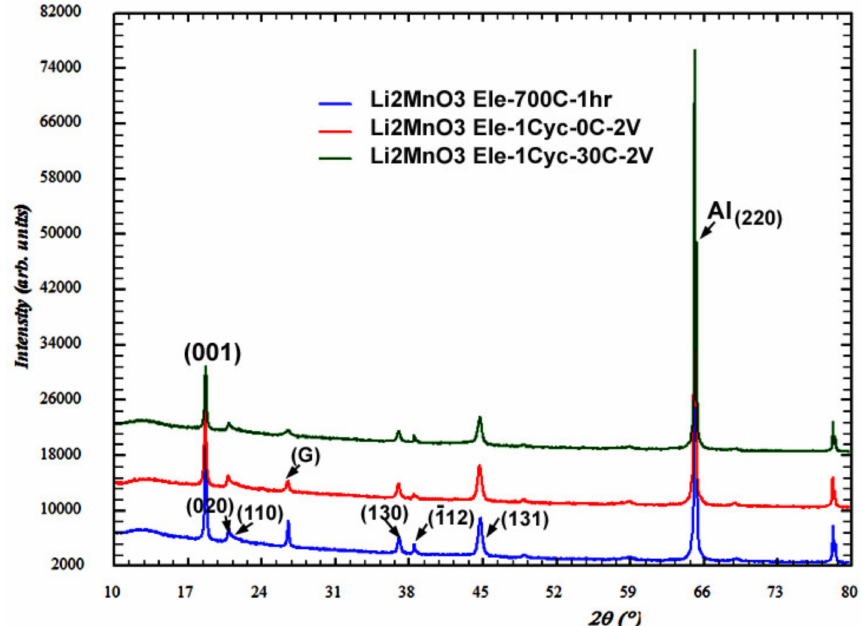
Figure 7. Comparison of XRD patterns recorded from Li 2 MnO 3 electrodes on the Al-foil current collectors. Label G is related to a graphite peak, the peak at 2 ϑ = 65.1 ◦ is associated with (220) reflection from Al-foil. Blue, red and green profiles correspond, respectively, to as-prepared (annealed) powder and to electrodes subjected to the first charge–discharge cycle at 0 ◦ C and 30 ◦